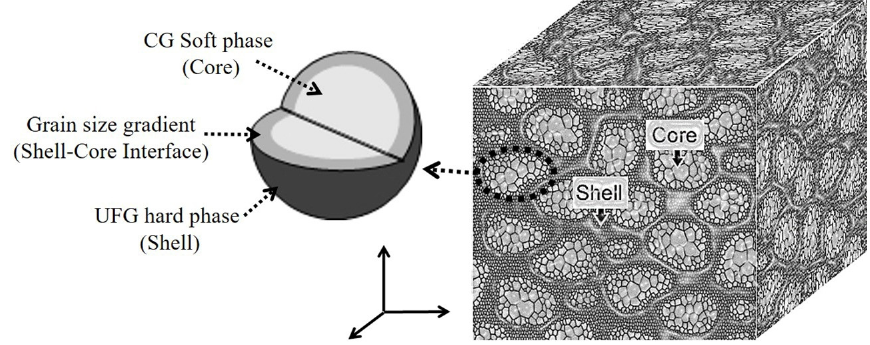
Figure 2. Concept of the harmonic structure (HS) design.